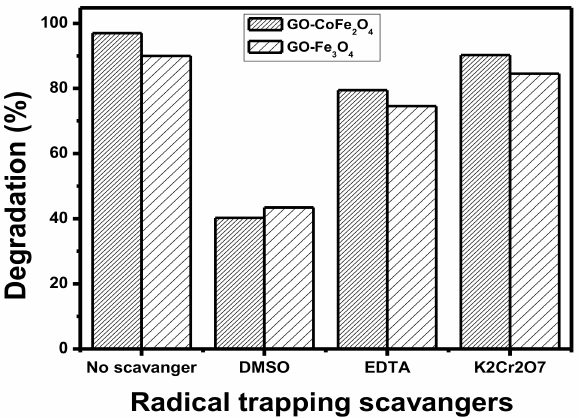
Figure 4. Radical scavenging experiment for the degradation of Acetamiprid under optimized conditions using GO-CoFe 2 O 4 and GO-Fe 3 O 4